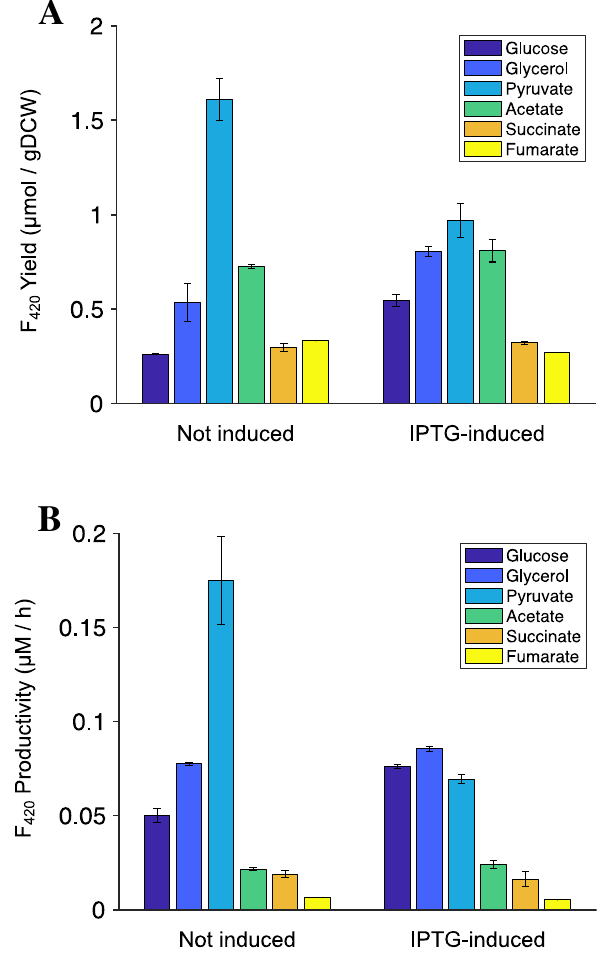
Figure 6. Effect of PPS over-expression on ( A ) F 420 yield with and without IPTG (0.1 mM) induction; ( B ) F 420 productivity (µM/h) with and without IPTG (0.1 mM). Leaky expression of PPS was observed without the addition of IPTG (Supplementary Fig. S3). E. coli was cultivated in a minimal media with different sole carbon sources as shown. Error bars show standard errors of the mean of at least two